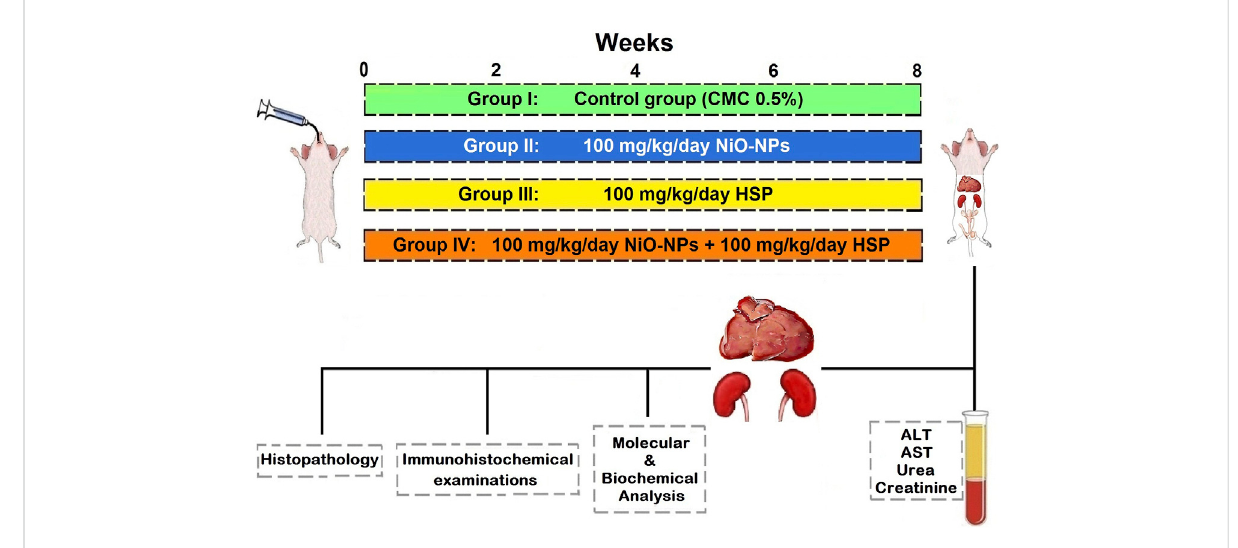
FIGURE 1 A schematic diagram showing the experimental